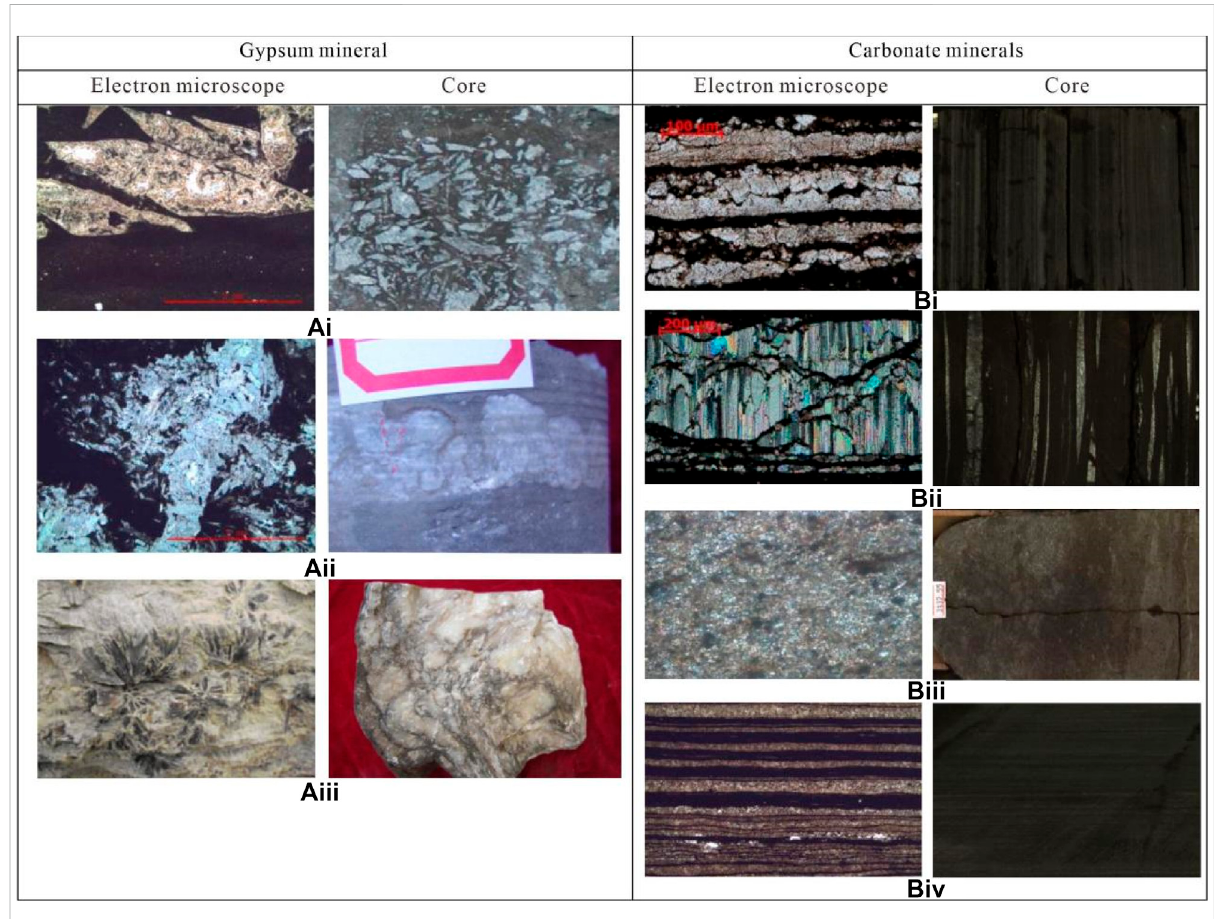
FIGURE 4 CharacteristicsofsaltmineralsintheDongyingSag. (Ai) .Swallow-tailed. (Aii) Creepstate. (Aiii) Branch. (Bi) Lamellar. (Bii) Lentoid. (Biii) Massive. (Biv)